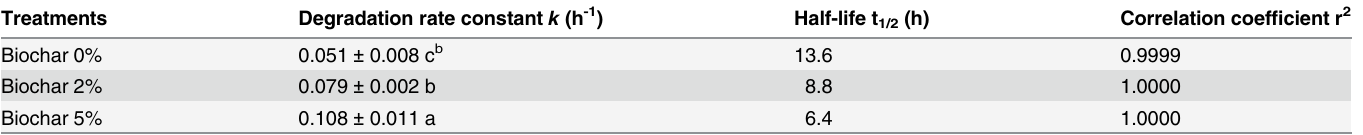
Table 3. Effects of biochar on CP degradation in soil a .